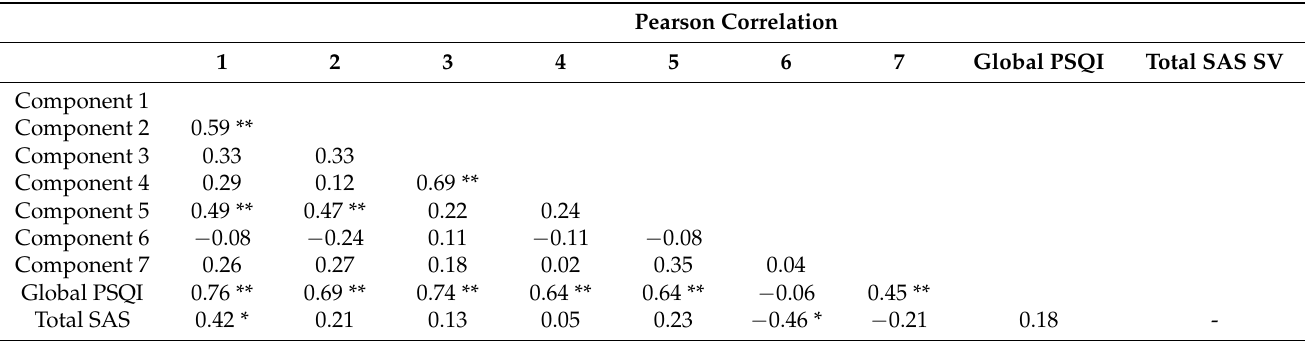
Table 7. Convergent validity and discriminant validity of the pilot study. Pearson Correlation